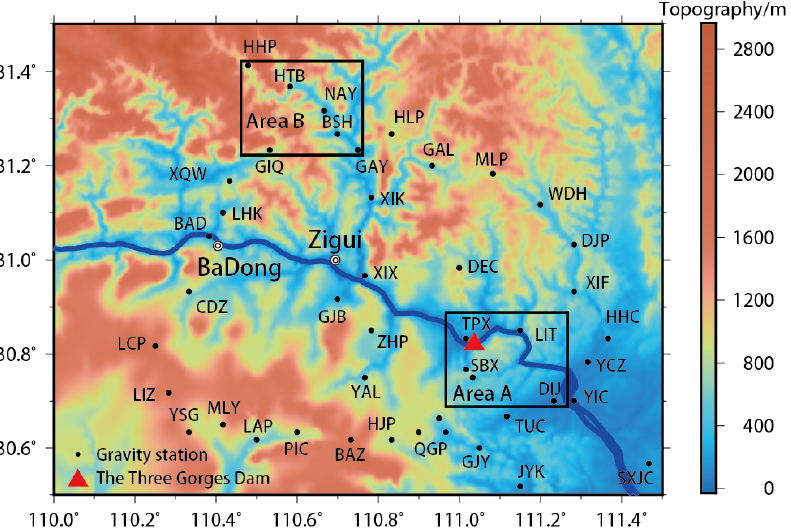
Figure 2. Codes of the gravity station and area selection for the interpolation algorithms: A represents riverside and B hills.